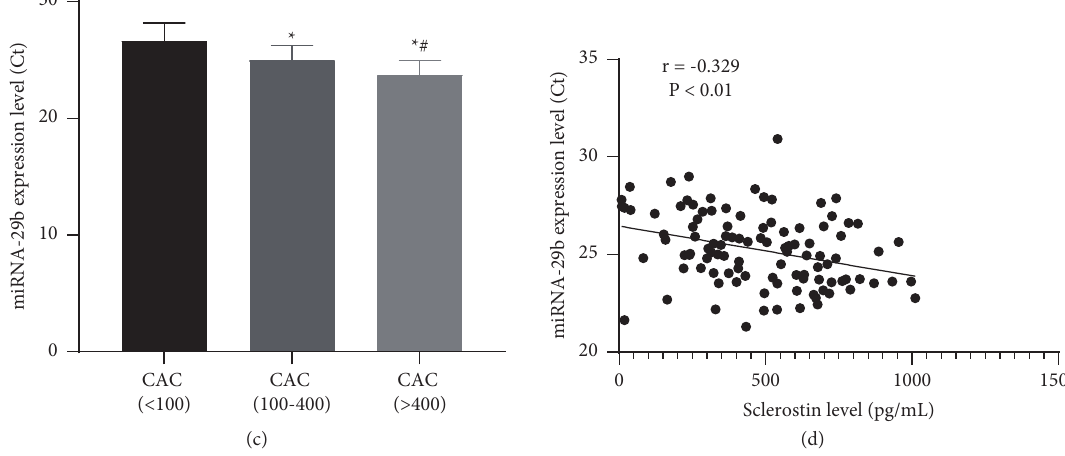
Figure 1: Serum levels of sclerostin and miRNA-29b were correlated with CAC in MHD patients. (a) The serum level of sclerostin among the CAC ( < 100) ( n � 44), CAC (100–400) ( n � 27), and CAC ( > 400) ( n � 34) groups was determined by ELISA. (b) A miRNA-mRNA target prediction using the RNA22 database presented sclerostin as the target of miRNA-29b. (c) The serum expression level of miRNA-29b (Ct) among the CAC ( < 100) ( n � 44), CAC (100–400) ( n � 27), and CAC ( > 400) ( n � 34) groups was determined by RT-qPCR. (d) A negative